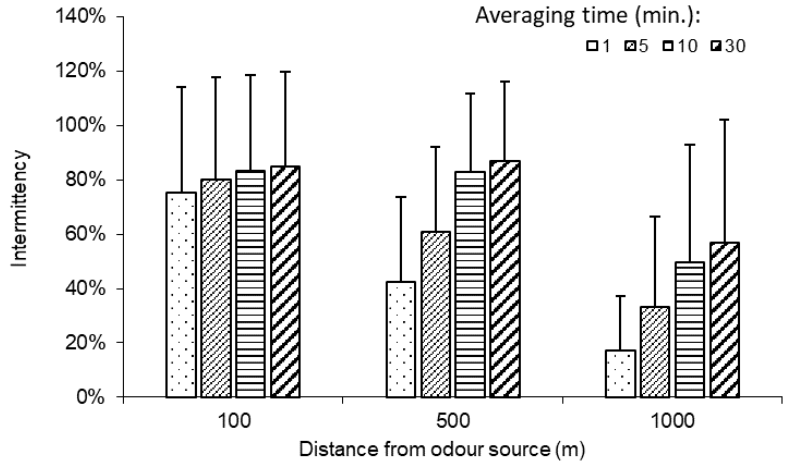
Figure 5. Intermittency measured along the wind direction at 100, 500, and 1000 m from odour source (bar: standard deviation).